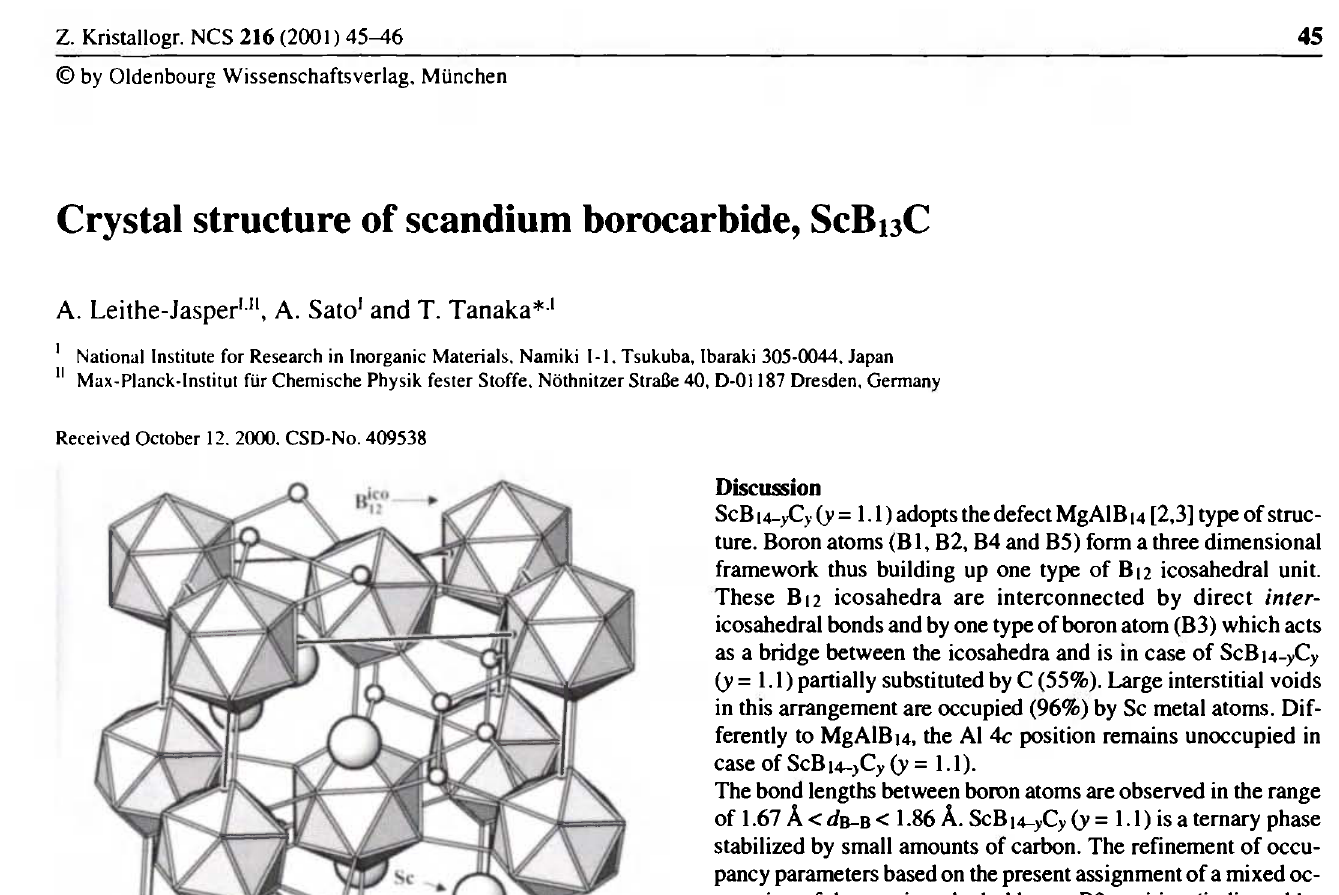
Table 1. Data collection and handling.